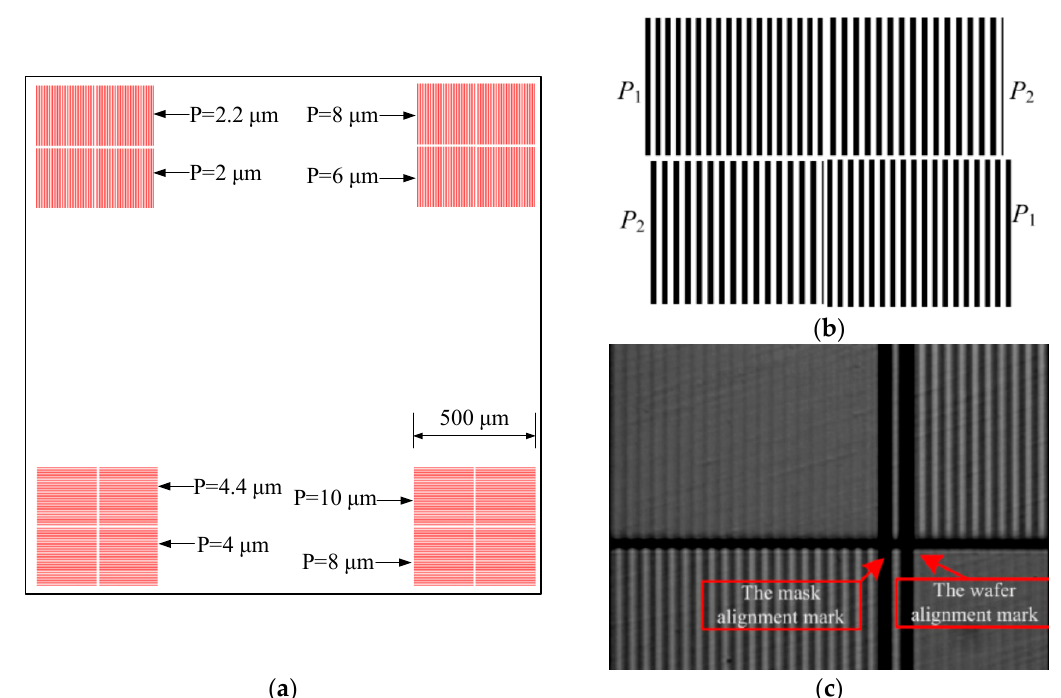
Figure 6. Four-quadrant gratings. ( a ) Complete alignment mark. ( b ) Enlarged view of complete mark. ( c ) Moiré fringe image.